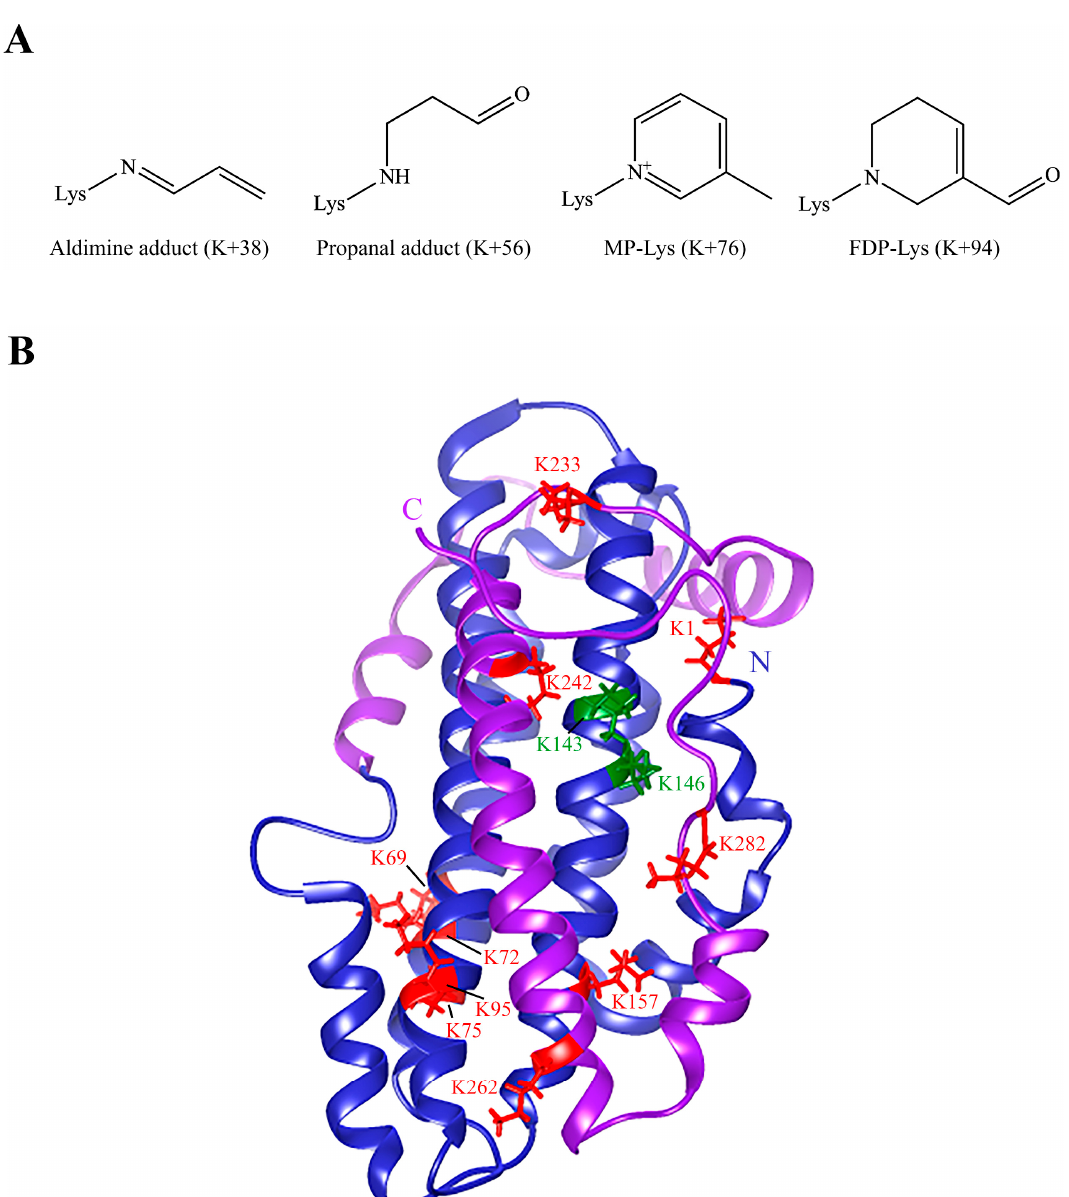
Figure 8. Acrolein modification of apoE3. Panel ( A ) Structures of acrolein adducts identified in acro- apoE3. The numbers in parentheses indicate the observed increase in mass units based on mass spectral analysis. ( B ) Structure of apoE3 showing acrolein-modified Lys. The overall organization